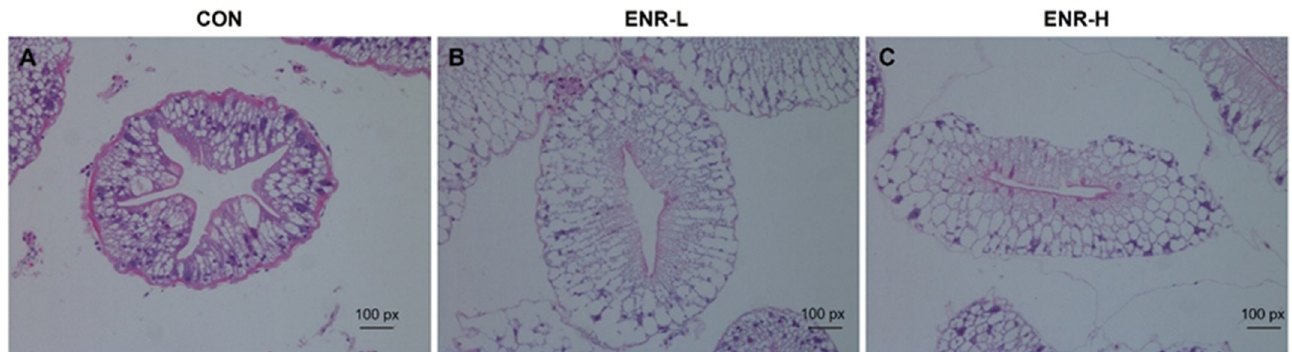
Figure 1. Hematoxylin and eosin staining of E. sinensis hepatopancreas specimens following en- rofloxacin exposure at different doses. ( A ) CON represents the control group, ( B ) ENR-L represents the low-concentration enrofloxacin residue group, and ( C ) ENR-H represents the high-concentration enrofloxacin residue group.